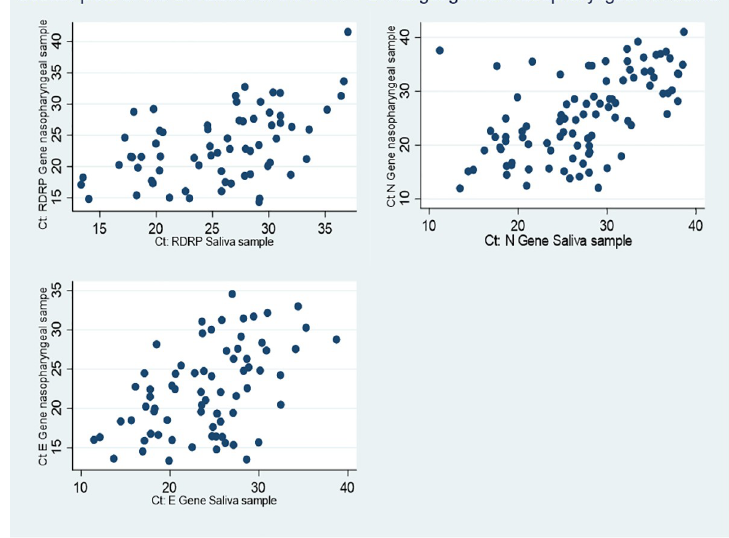
Fig 3. Different gene target Cts on saliva and nasopharyngeal samples. Scatterplots between gene target Ct results for nasopharyngeal (y axis) and saliva samples (x axis) for RdRp Gene (top left), N Gene (top right), and E Gene (bottom